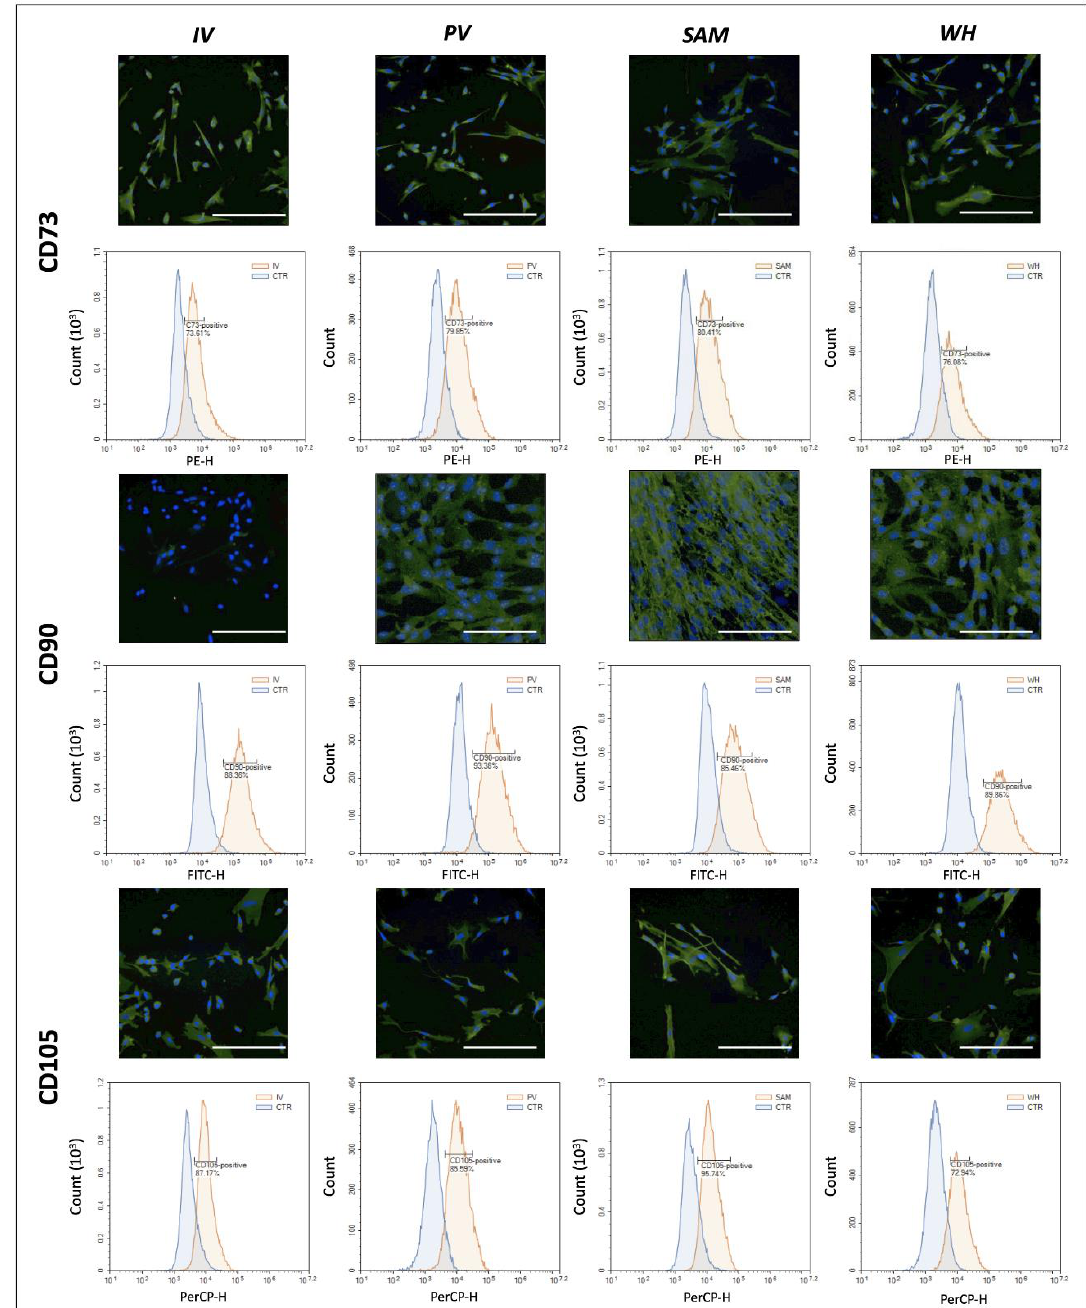
Figure 3. Analysis of relevant MSC markers in cells isolated from each zone of the human umbilical cord (hUC-MSC). For each marker, immunofluorescence images and flow cytometry distributions are shown. In the immunofluorescence images, a positive signal is shown in green, whereas cell nuclei are shown in blue. Scale bar = 200 µm.